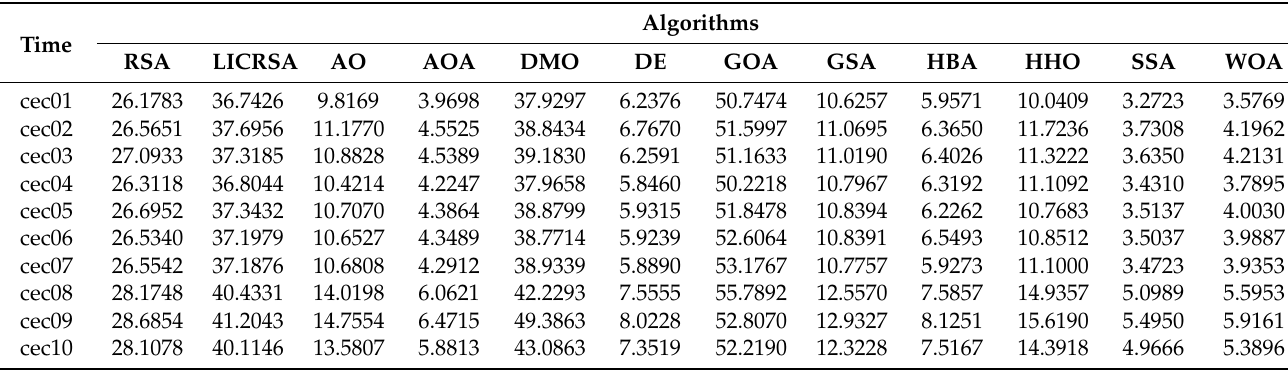
Table 6. Run time of LICRSA and other search algorithms on